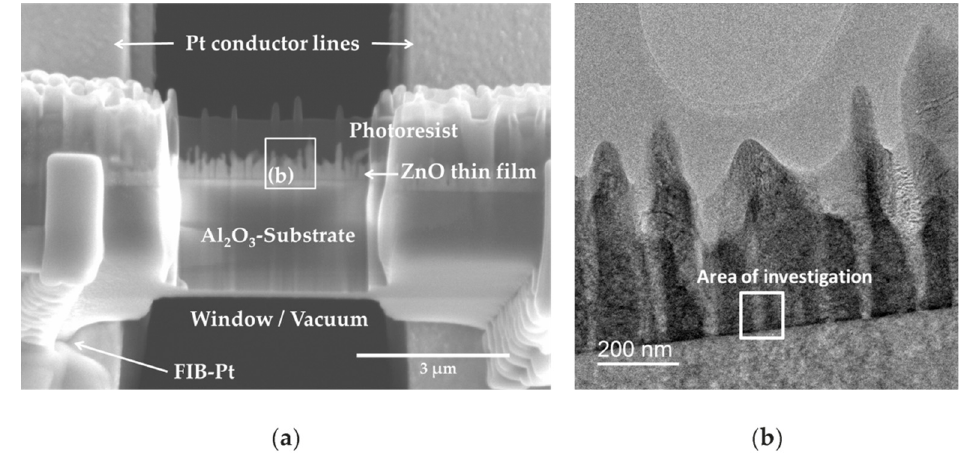
Figure 4. ZnO thin film TEM specimen. ( a ) Photoresist coated ZnO thin film on Al 2 O 3 substrate lamella, thinned and mounted on a DENSsolutions MEMS chip using FIB. ( b ) Lamella at higher magnification indicating the area used for in-situ TEM examination.